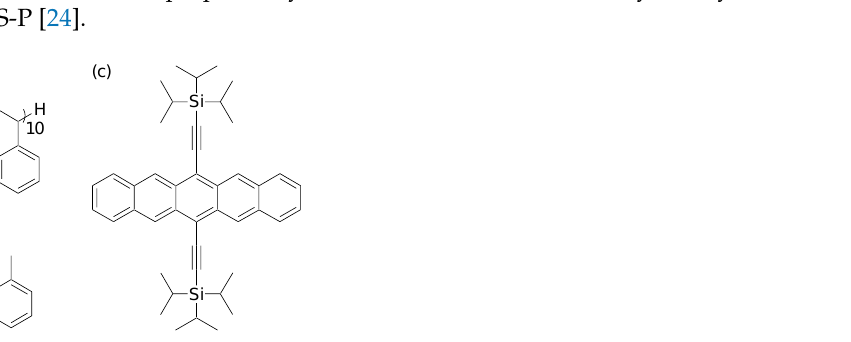
Figure 1. Molecular formulas of ( a ) polystyrene, C 80 H 82 ; ( b ) toluene, C 7 H 8 ; and ( c ) TIPS-P, C 44 H 54 Si 2 .